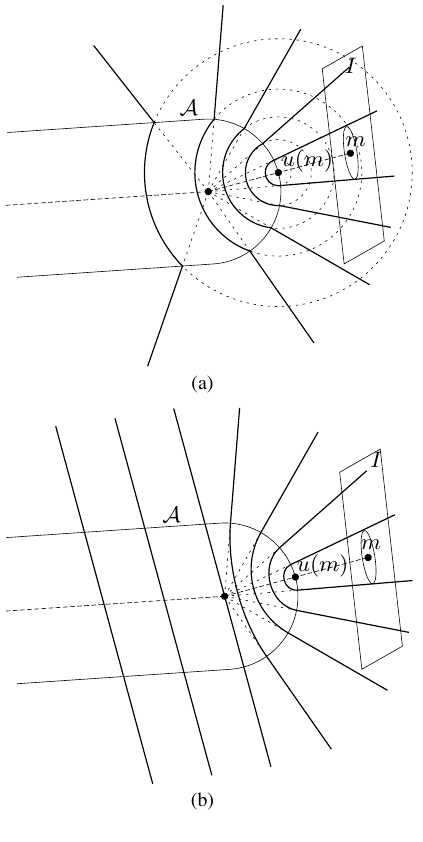
Figure 5. (a) Iso-level surfaces of | F m | (bold solid lines). (b) Design of iso-level surfaces for a quasiconvex